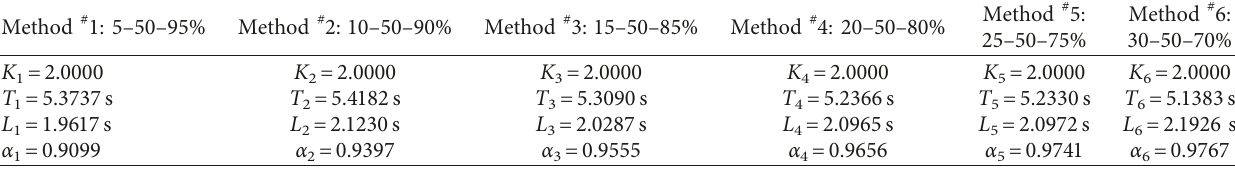
Table 21: FFOPDT model parameters for the considered sets of representative points (5–50–95%), (10–50–90%), (15–50–85%),